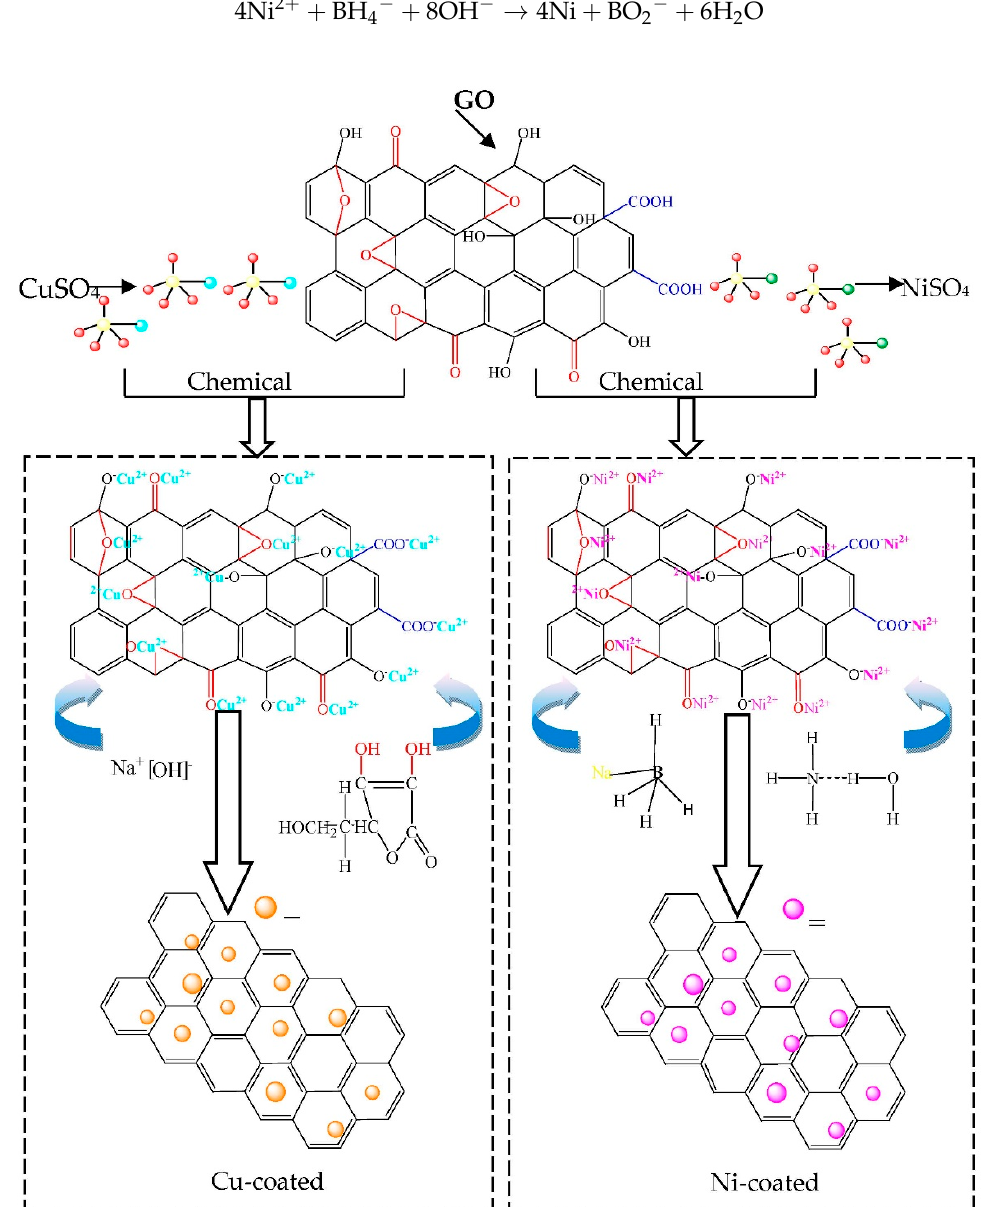
Figure 13. Schematic illustration of reaction mechanism of Cu@graphene and Ni@graphene.